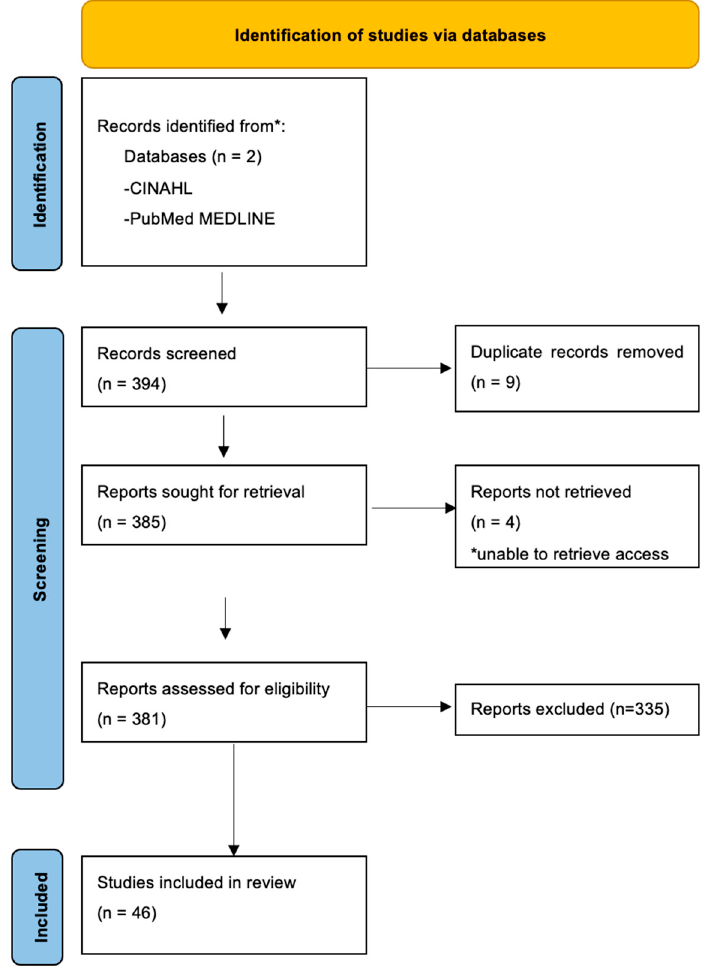
Figure 1. Search of Literature on CAM use in pediatric populations with Epilepsy. * Articles were excluded if access was unavailable through our institutions.